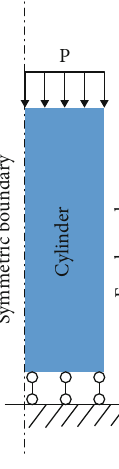
Figure 8: Boundary condition of circular pile.